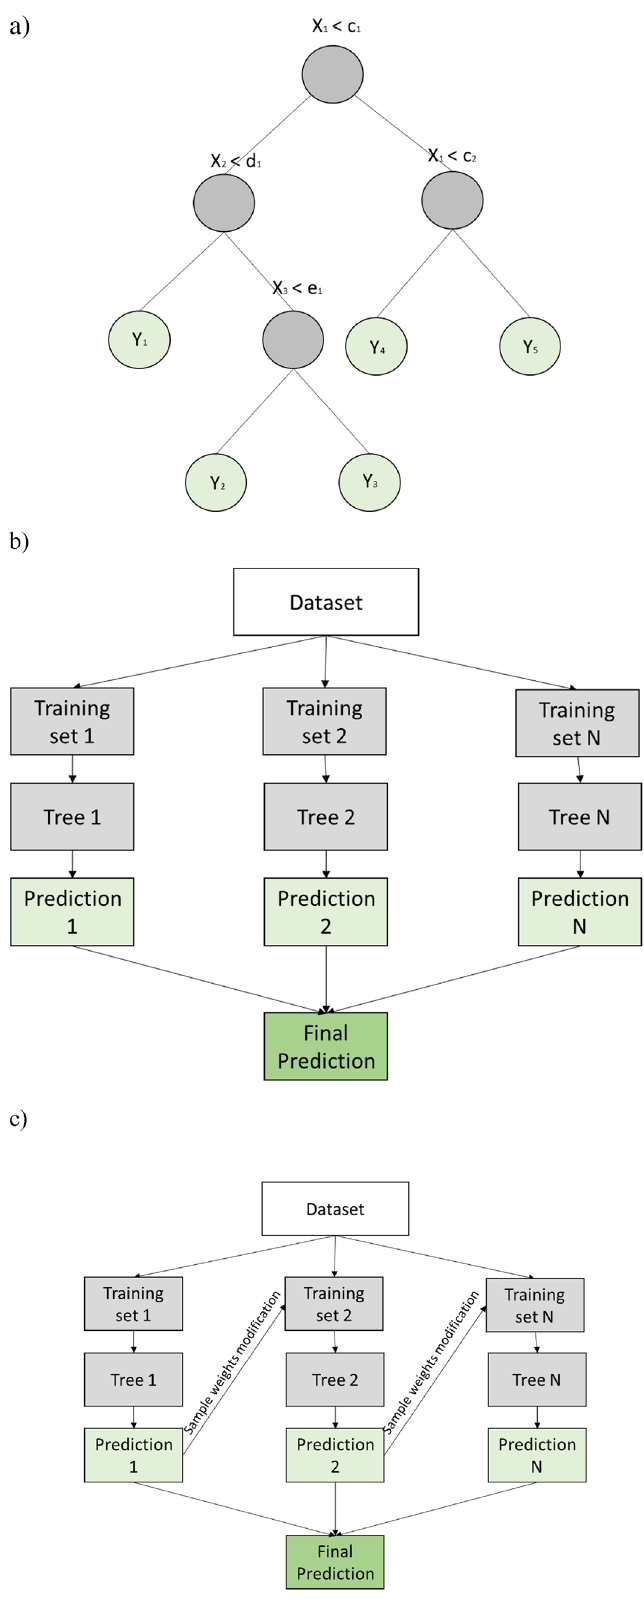
Figure 4. Schemes of ensemble models: ( a ) decision tree, ( b ) random forest and ( c )